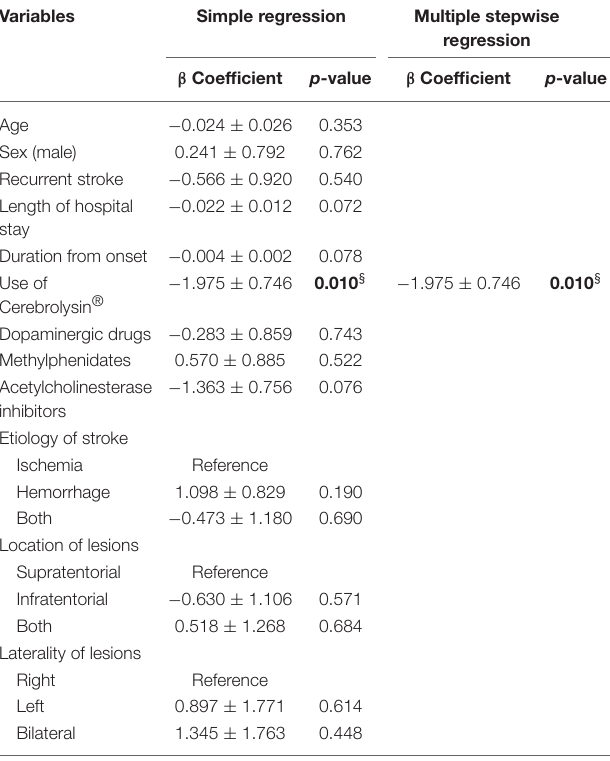
TABLE 3 | Results of simple and multiple regression analyses of CRS-R improvement in all